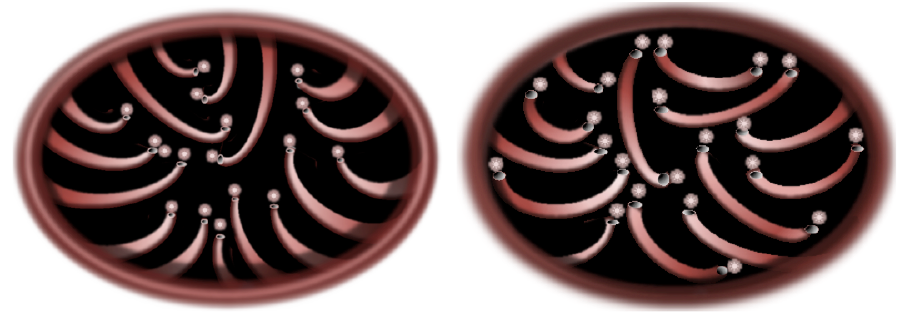
Figure 1: Two possible quantum entanglement patterns of de Sitter space with a one-sided horizon. The entanglement between EPR pairs is represented pictorially by tiny ER-bridges. The entanglement is long range and connects bulk excitations that carry the positive dark energy either with the states on the horizon (left) or primarily with each other (right). Both situations leads to a thermal volume law contribution to the entanglement